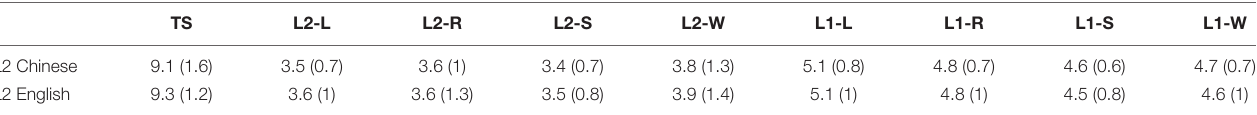
TABLE 1 | Proficiency information for L2